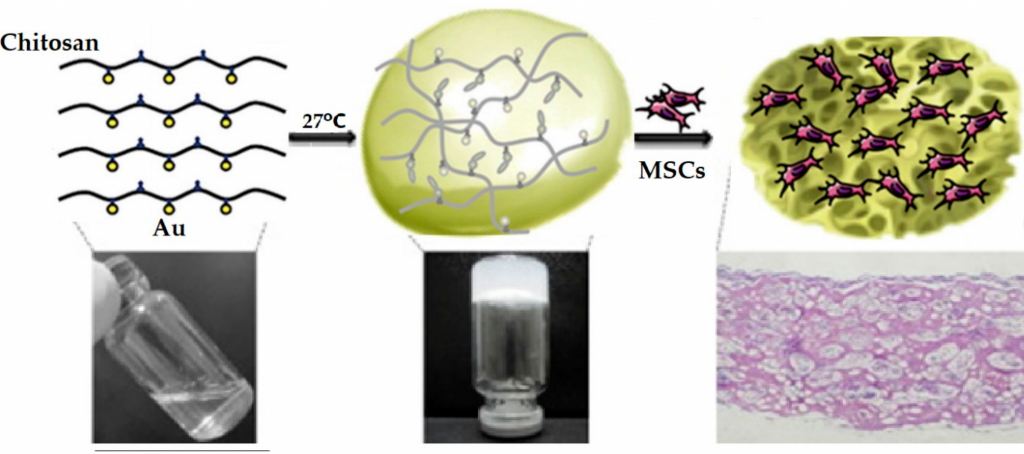
Figure 2. Thermosensitive conducive hydrogel by combining AuNPs with chitosan. The potential of AuNPs as a material of conductive hydrogel was confirmed (reproduced from [34] with permission, copyright Elsevier,